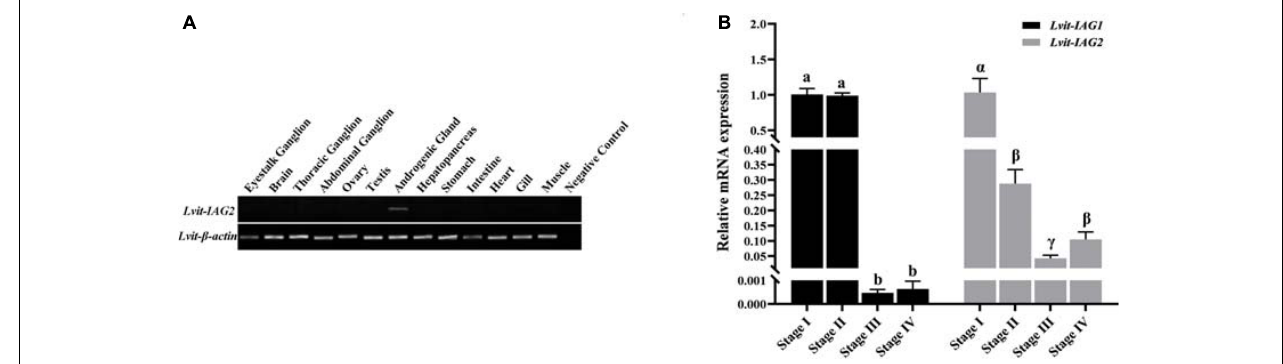
FIGURE 3 | Spatial expression profile of Lvit-IAG2 and temporal expression profiles of Lvit-IAG2 and Lvit-IAG1. (A) Distribution of Lvit-IAG2 in different tissues of L. vittata . The analysis was generated by PCR assays with cDNAs from various tissues of individuals at the gonadal development stage I. The Lvit- β -actin gene was used as a reference control gene. (B) Expression profiles of Lvit-IAG2 and Lvit-IAG1 in the androgenic gland during gonad development by qRT-PCR. The Lvit-IAGs expression levels standardized by Lvit- β -actin expression levels were represented as mean ± SEM (“a, b, and c,” p < 0.05; “ α , β , and γ ,” p < 0.05; one-way ANOVA followed by Tukey’s multiple range tests; n = 5).